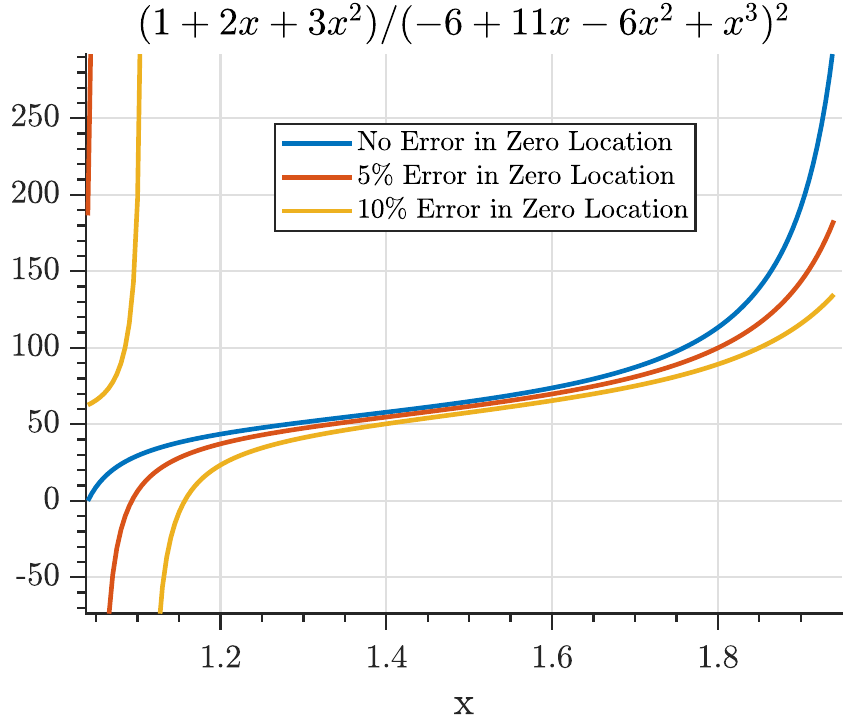
Figure 3. Plot of the closed-form solution shown in Figure 2 for increasing error at the location of the